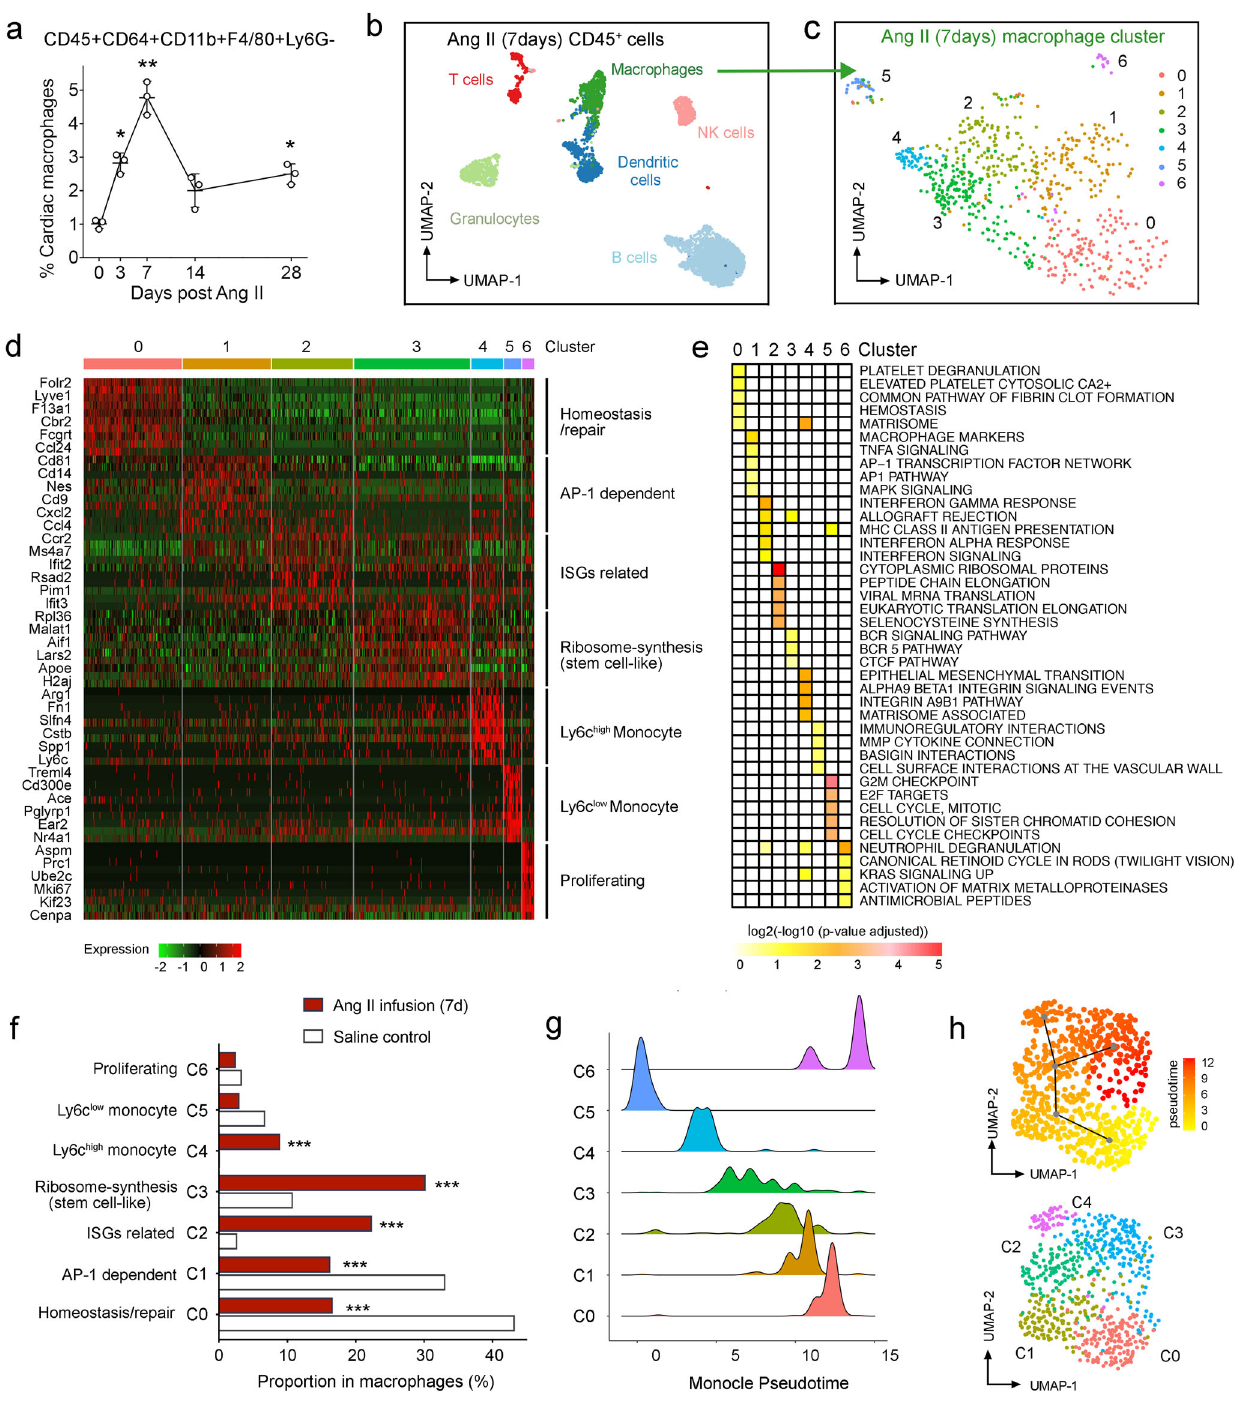
Fig. 1 | Single-cell transcriptomic pro fi ling and trajectory analysis of cardiac macrophages in a murine model of NICM. a Dynamics of cardiac macrophages (live CD45+ CD64+ CD11b+ F4/80+ Ly6G − ) from B6J mice treated with Ang-II (500ng/kg/min). Cardiac macrophages are shown as a percentage with respect to total number of cardiac cells. Three biological replicates were used at each time point. P -values calculated by Mann – Whitney U test, vs percentage at day 0. * P <0.05, ** P <0.01. b Cardiac CD45+ cells sorted from left ventricle (LV) from B6J mice treatedwith Ang-II (500ng/kg/min, 7 days) and saline (controls) were pooled for scRNA-seq analysis on 5497 cells. Global uniform manifold approximation and projection(UMAP)dimensionreductionanalysisidenti fi ed sixmajorcelltypes.DC dendritic cells, NK cells natural killer cells. c Macrophages were re-clustered using Seurat ’ s Louvain clustering. d Heatmap of the scaled gene expression of top 10 markers for each macrophage cluster from Fig. 1c, based on average log 2 fold